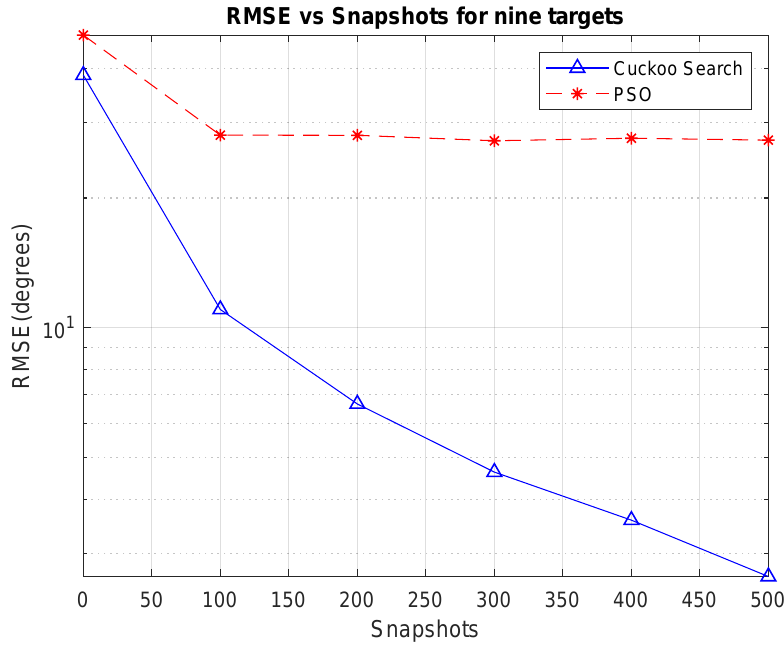
Figure 8. Estimation of robustness using nine sources in terms of snapshots.